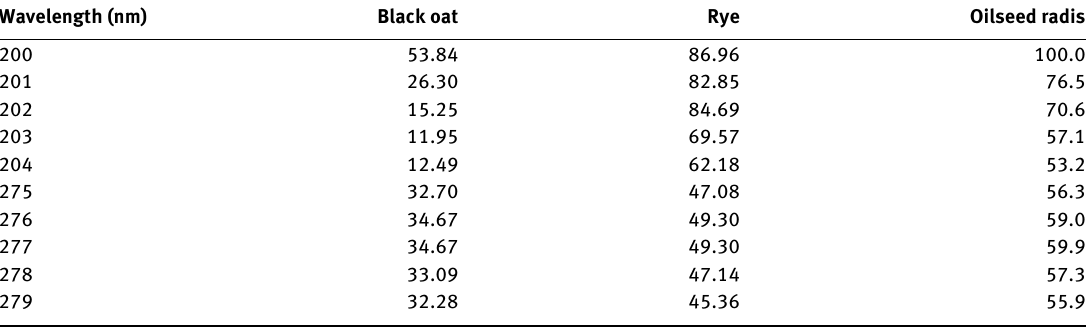
Table 2: Individual relative contribution (%) of the 10 wavelengths, in UV–vis, most relevant to the classification by species, of the samples the cover crops Avena strigosa L. (black oat), Secale cereale L. (rye) and Raphanus sativus L. (oilseed